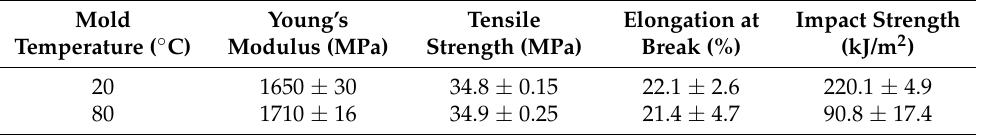
Table 4. Mechanical properties of PP conditioned samples after